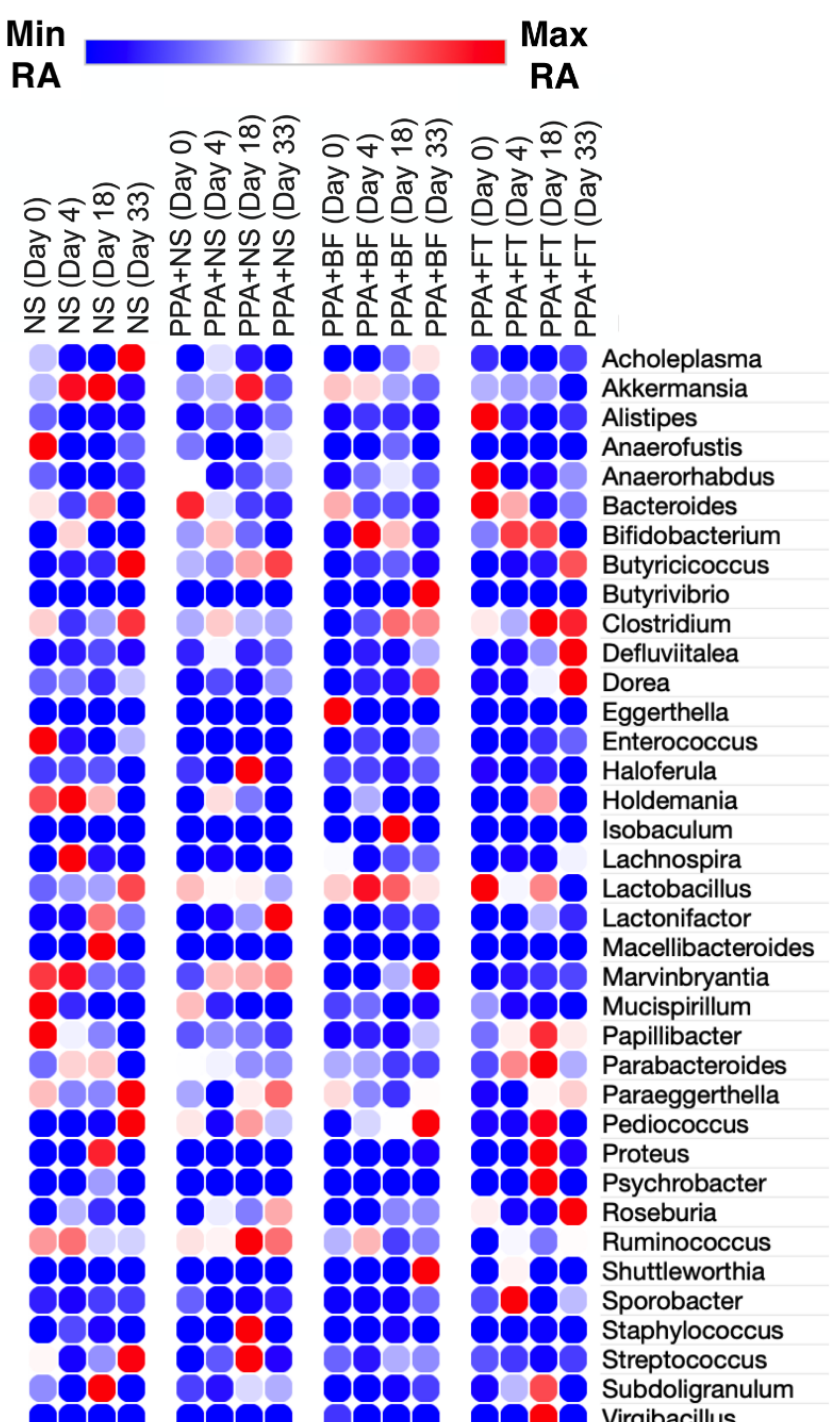
Figure 5 . Identified genera clustered by intervention group. Each circle represents the mean relative abundance of the identified genus from animals within a treatment group at each timepoint ( n = 5). NS, Normal saline control group; PPA + NS; propionic acid control group; PPA + BF, Bifidobacterium treated group; PPA + FT, fecal microbiota transplantation treated group. Scale represents a color scheme for the minimum and maximum relative abundance (RA) values in each row.